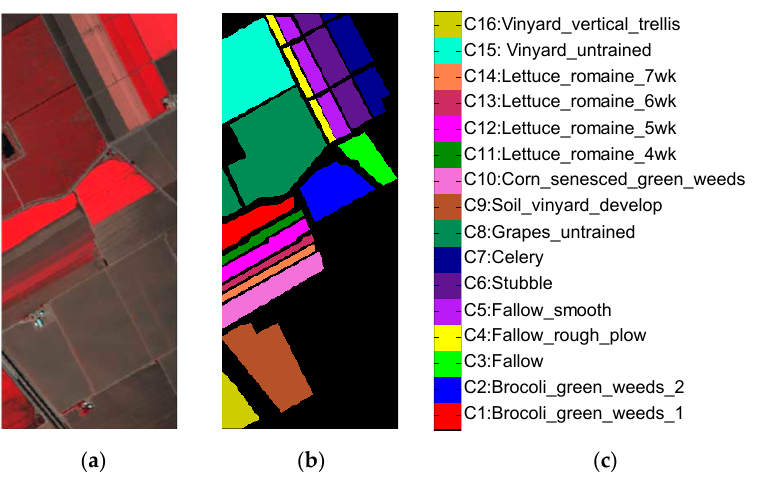
Figure 3. Salinas dataset with ( a ) original hyperspectral image, ( b ) ground truth, and ( c ) category names with labeled samples.